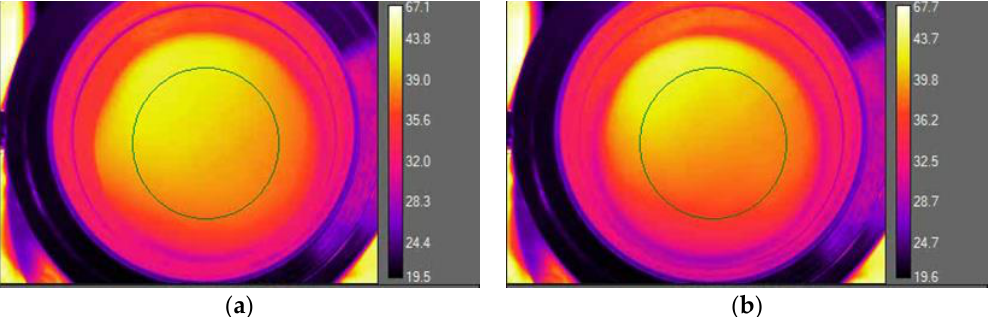
Figure 15. Thermograms of a material sample exposed to thermal radiation: PROTON without coating ( a ) and coated ( b ).